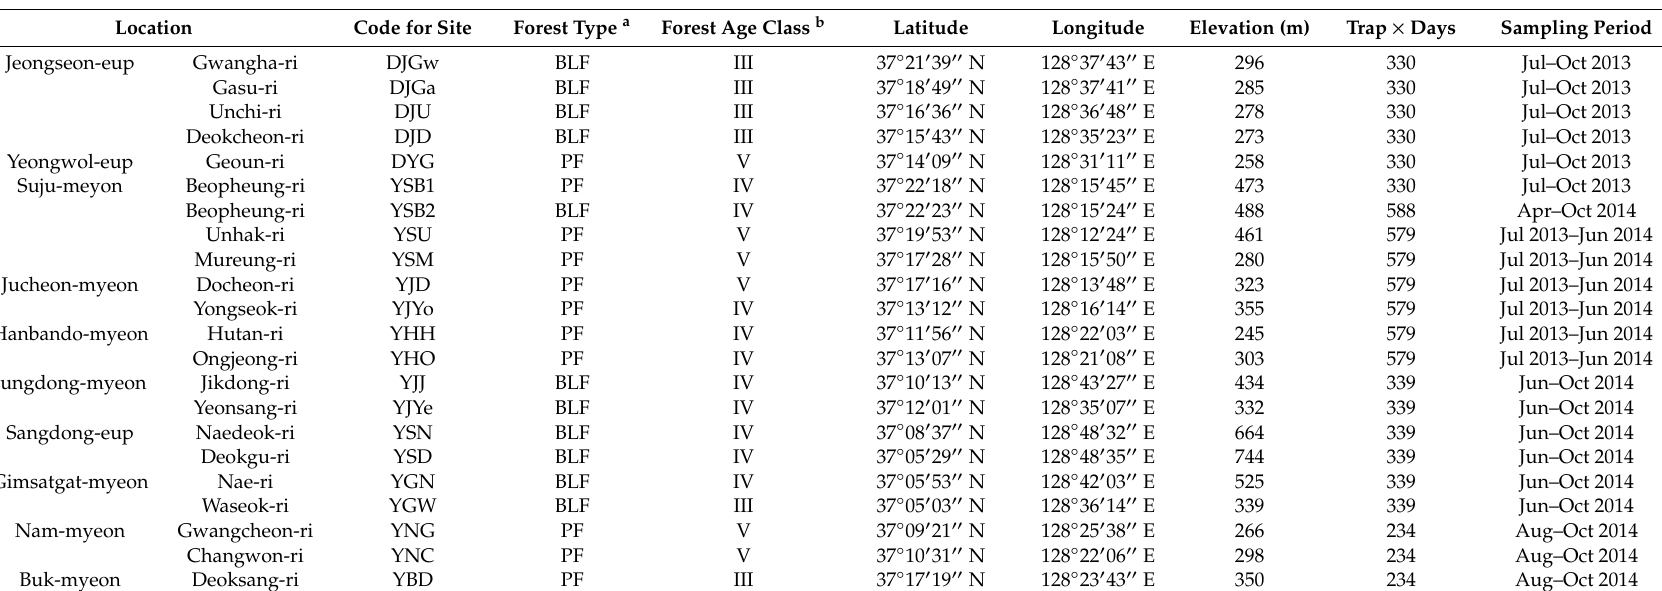
Table 1. Environmental characteristics for each study site with sampling